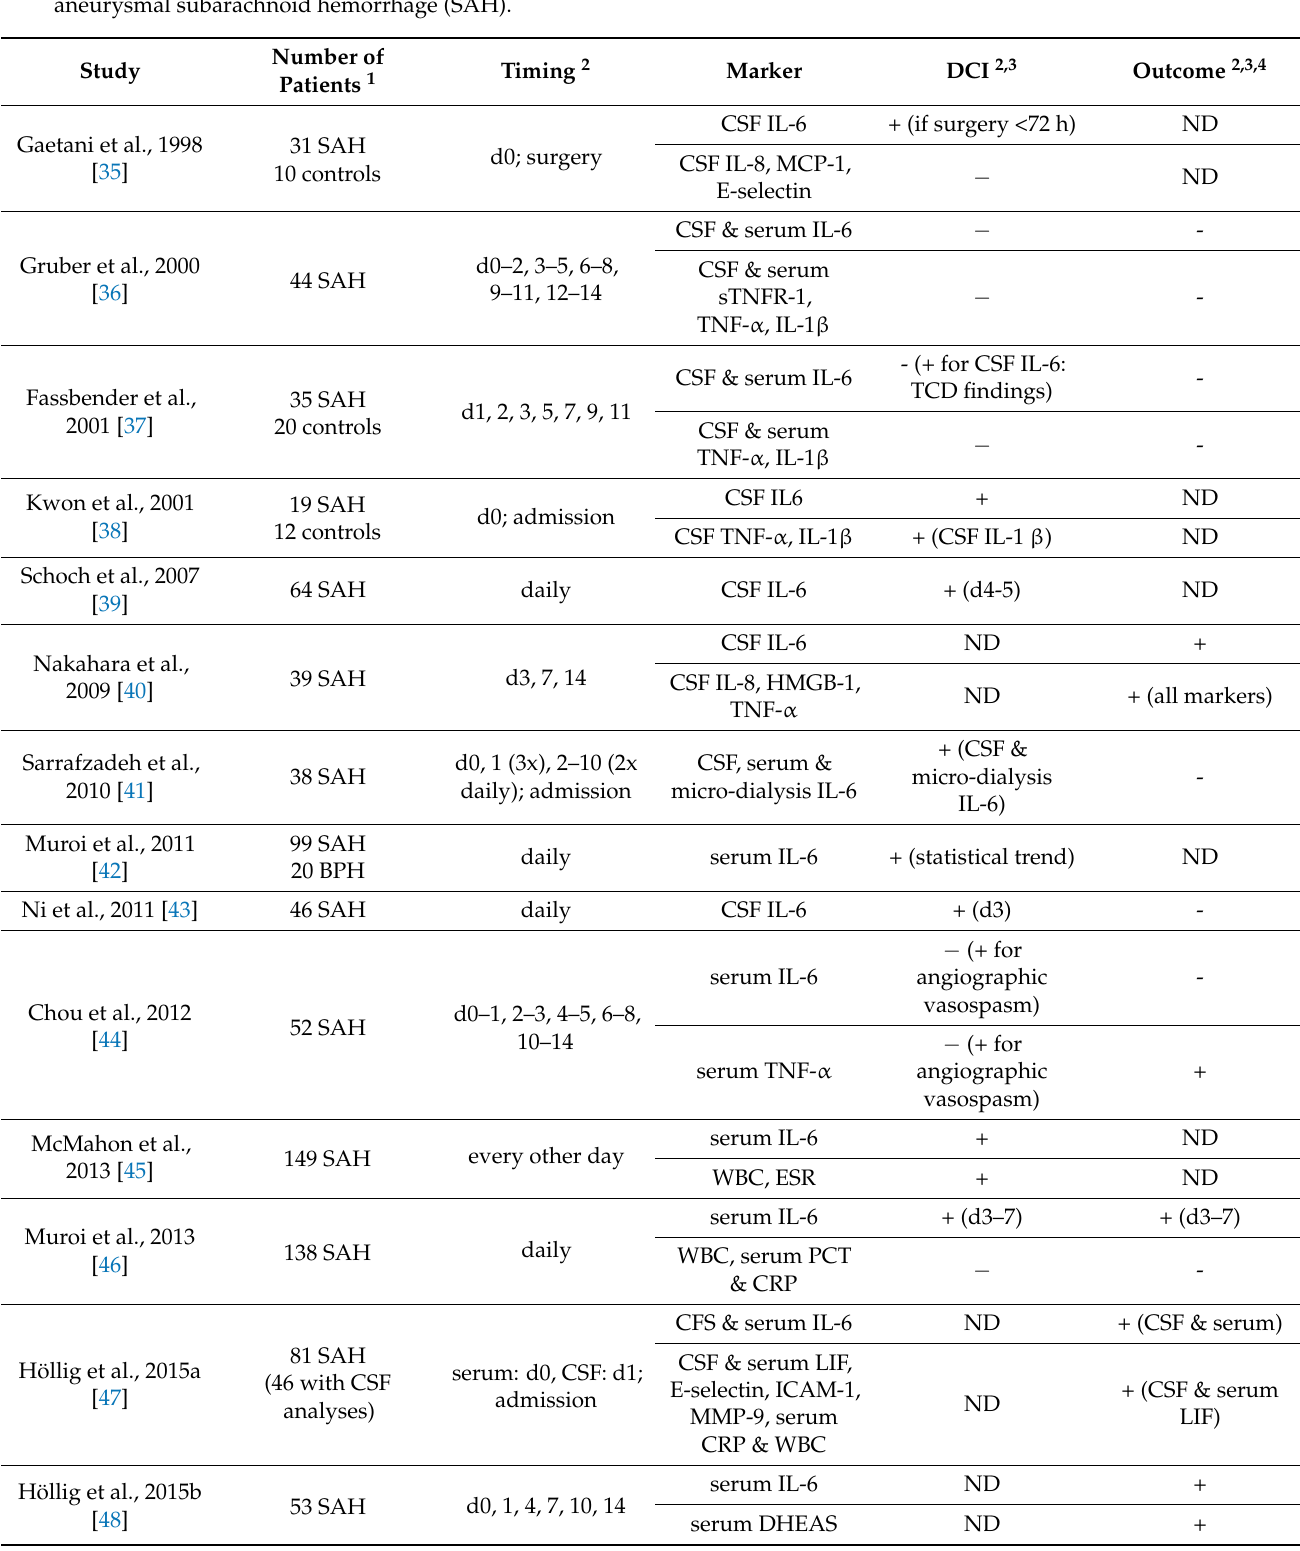
Table 1. Studies investigating IL-6 as biomarker for delayed cerebral ischemia (DCI) and functional outcomes after aneurysmal subarachnoid hemorrhage